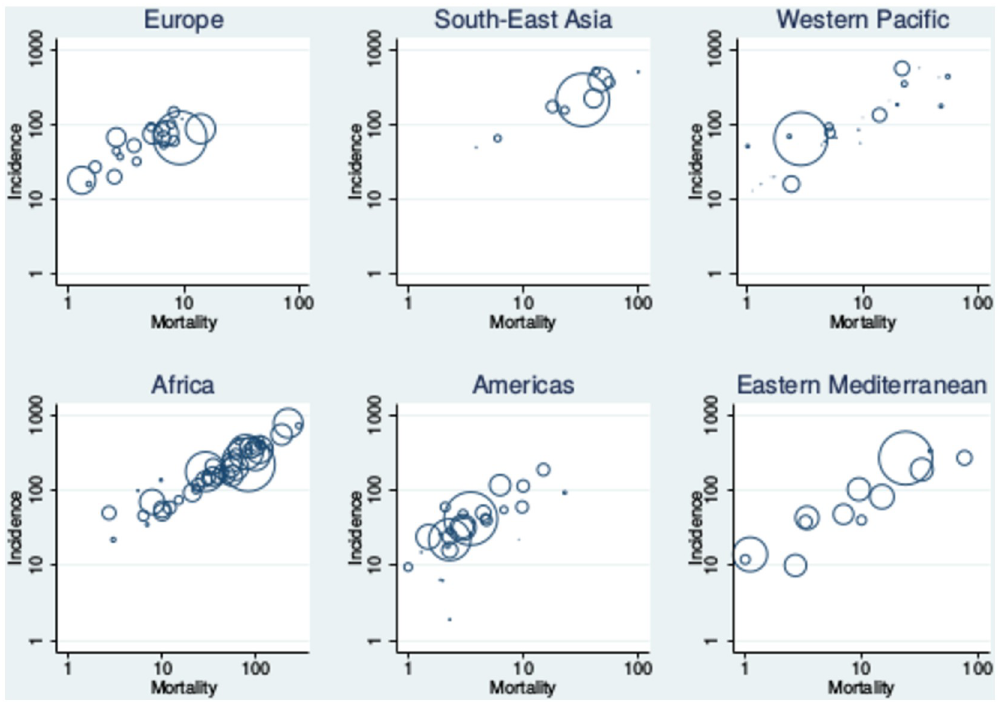
Fig 9. Illustration of world TB burden by WHO region obtained from the global TB Report data [6]. The size of the circle is proportional to the population of the country. Incidence is plotted relative to mortality not to illustrate the relationship between these two quantities, but rather as two complementary illustrations of disease burden. Clustering of countries into high and low burden groups is arguably observed to some degree, although this may be obscured by other epidemiological